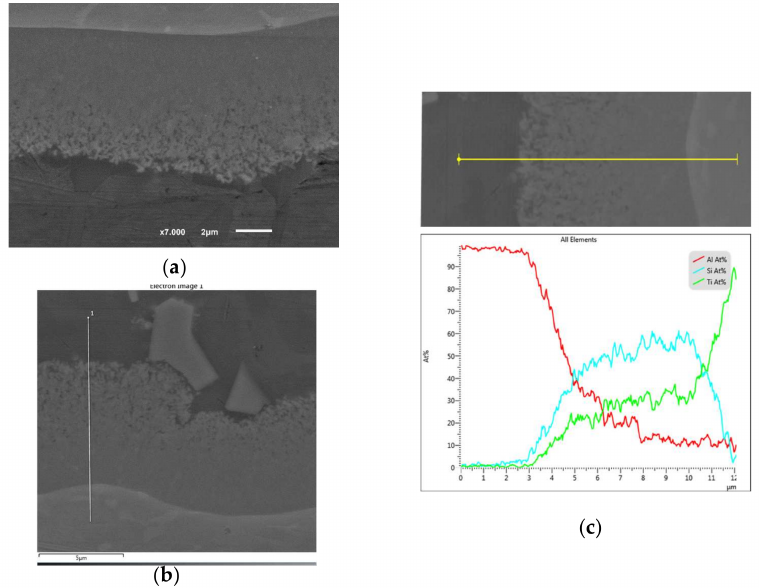
Figure 17. SEM images (SEI) of 13/680 joint interfaces at: ( a ) The active part of the parent metal; ( b ) The passive part; ( c ) EDS line position and analysis of the interface in ( b ). The interfaces show tiny laminar morphology of Ti 7 Al 5 Si 12 at the filler